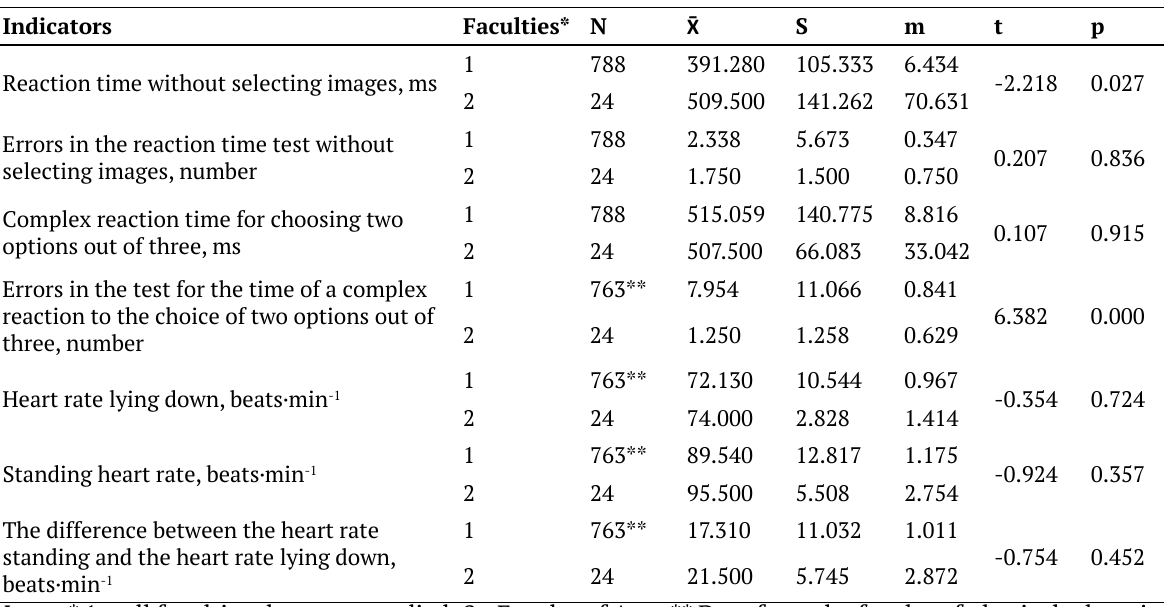
Table 1. Indicators of properties of the nervous system and functional capabilities of the cardiovascular system of students of the Faculty of Arts in comparison with students of other faculties Indicators